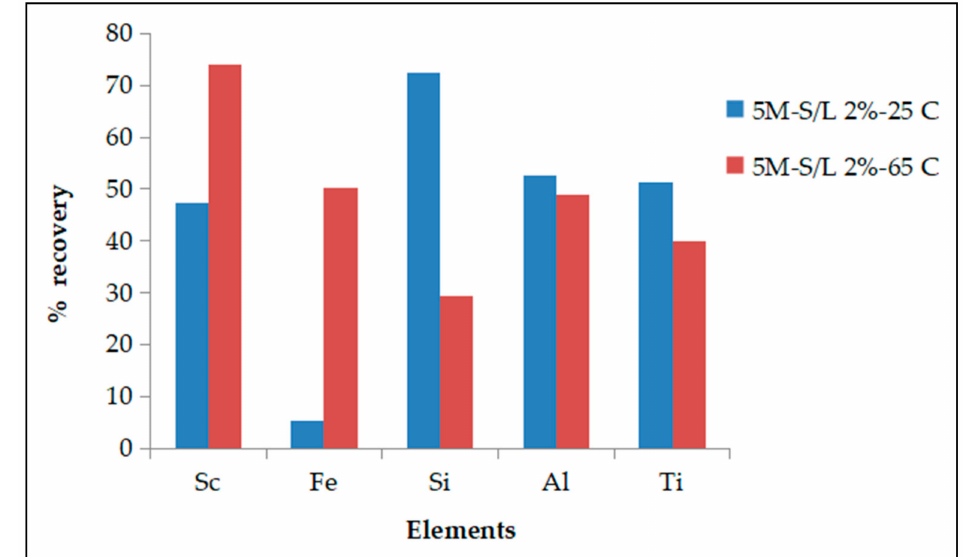
Figure 9. Effect of process